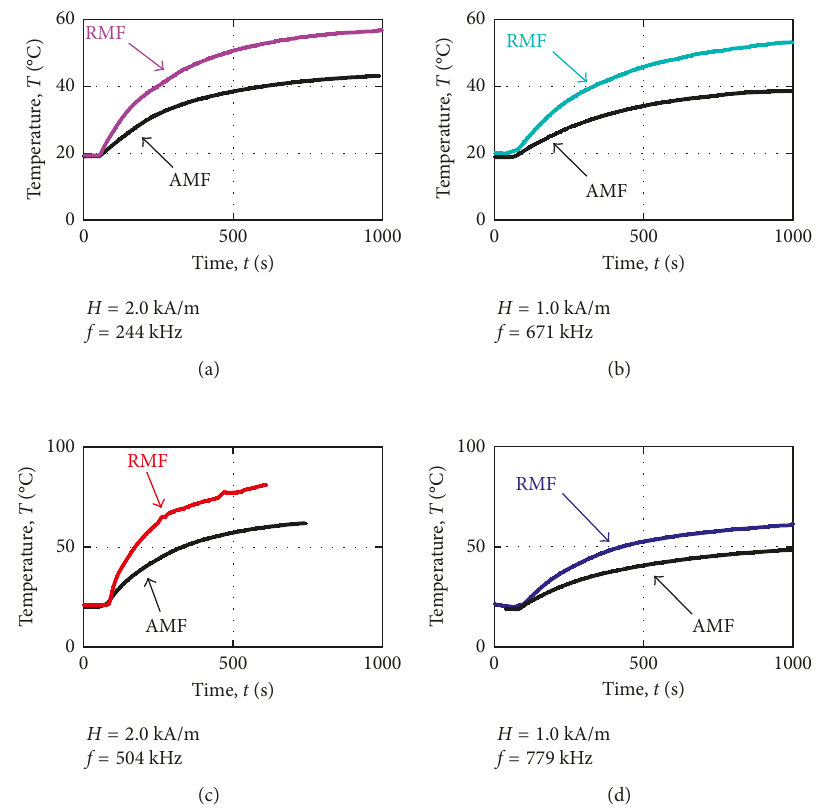
Figure 4: Comparison of the heating of the magnetic fluid sample exposed to AMF and RMF at different frequencies and